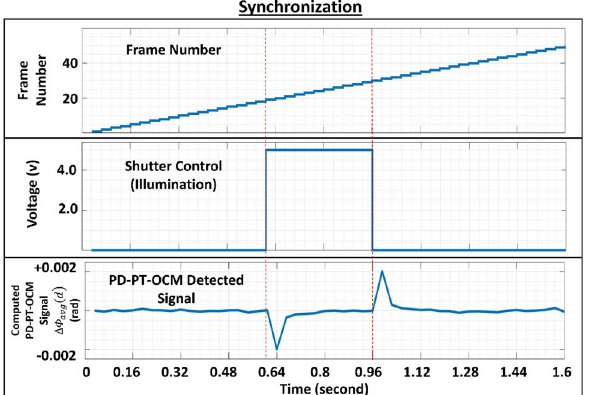
Figure 1. Relationship between frame number, shutter action, and photothermal response during an illumination cycle.